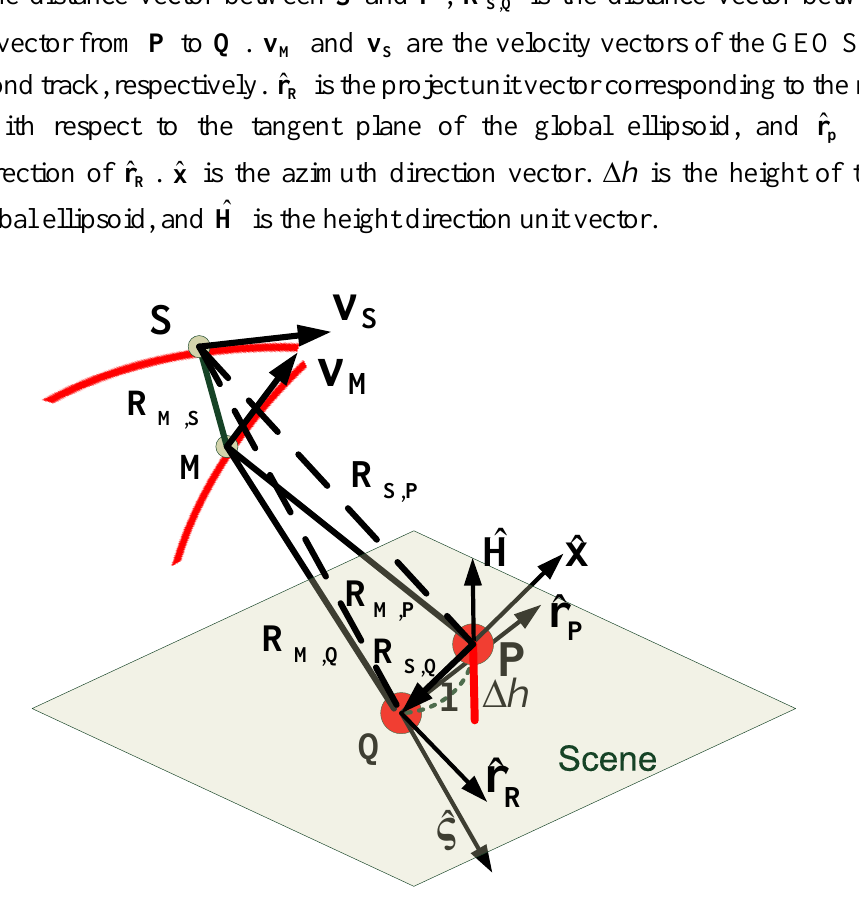
Figure 4. Sketch map of the GEO InSAR